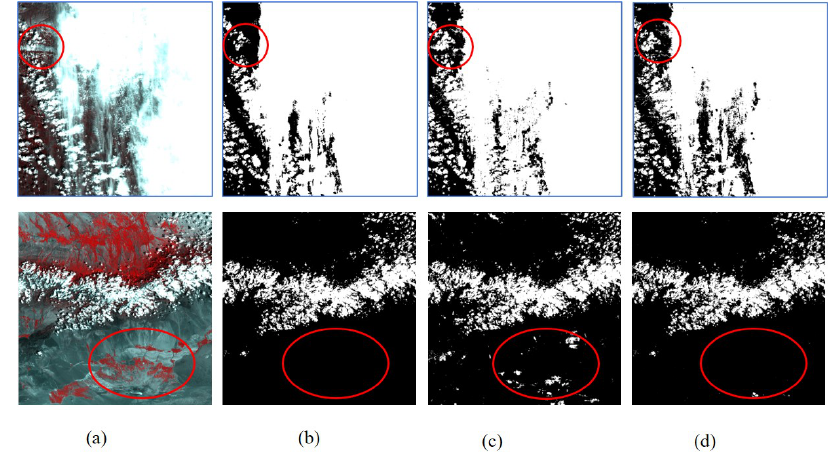
Figure 8. ( a ) NIR-R-G image, ( b ) ground truth, and masks generated by ( c ) U-Net and ( d )